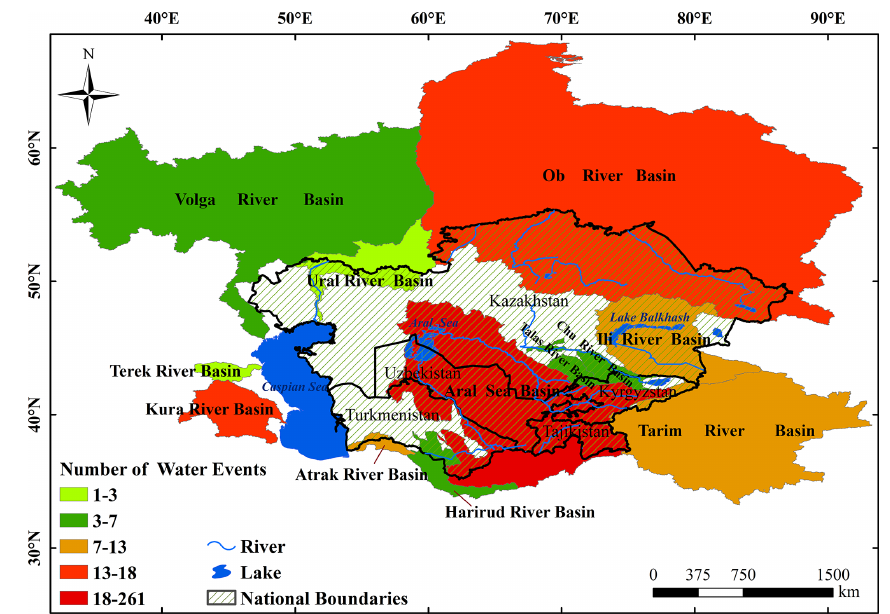
Figure 8. Spatial distribution of water political events in transboundary river basins in and around Central Asia from 1951 to 2018. The country borders are from the National Platform for Common Geospatial Information Services (https://www.tianditu.gov.cn/, last access: 4 December 2020; GS(2016)2948). The borders of international river basins are from the Transboundary Freshwater Dispute Database (https://transboundarywaters.science.oregonstate.edu/, last access: 4 December 2020).